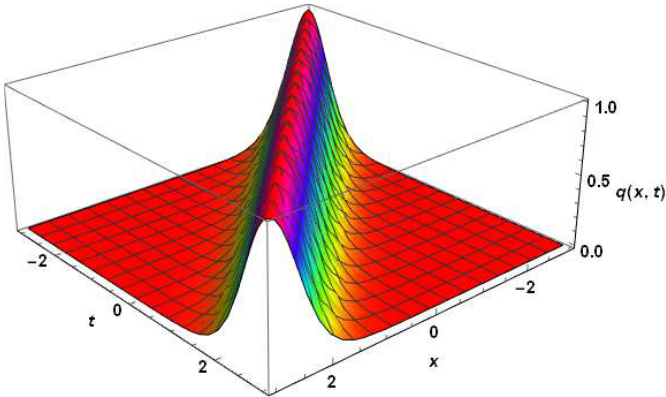
(cid:2869) (cid:2869) . (cid:2874) (cid:2874)